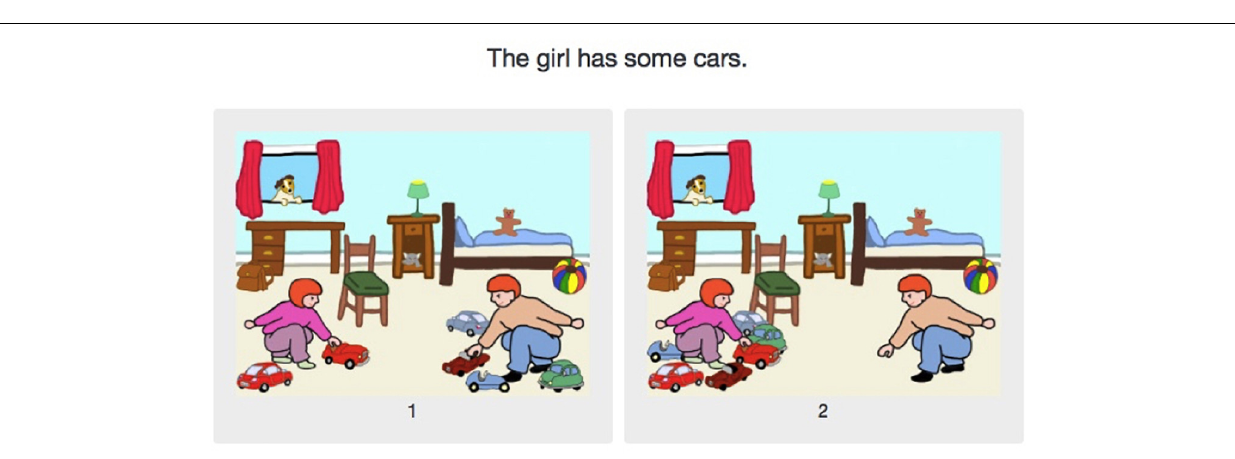
females). They were all native speakers of French. In addition, 34 English participants were recruited through the Prolific platform. They were all students, aged between 18 and 30